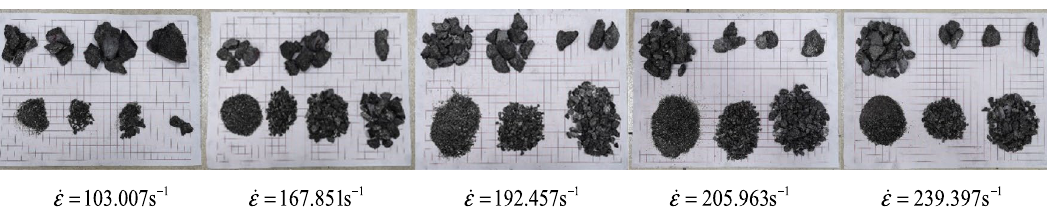
Figure 8. Sieving diagram of sample fragments at different strain